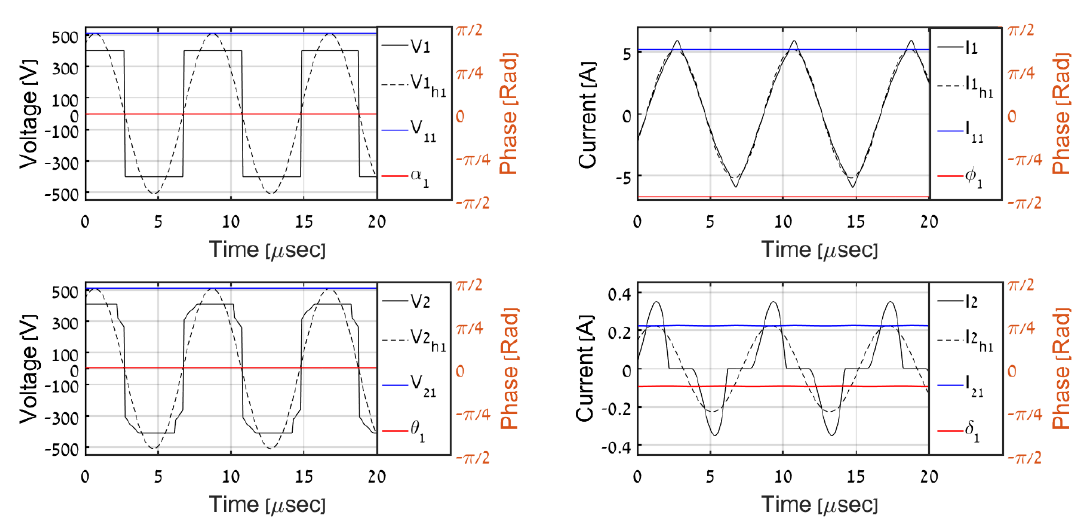
Figure 11. Simulation results, P O = 100 W.